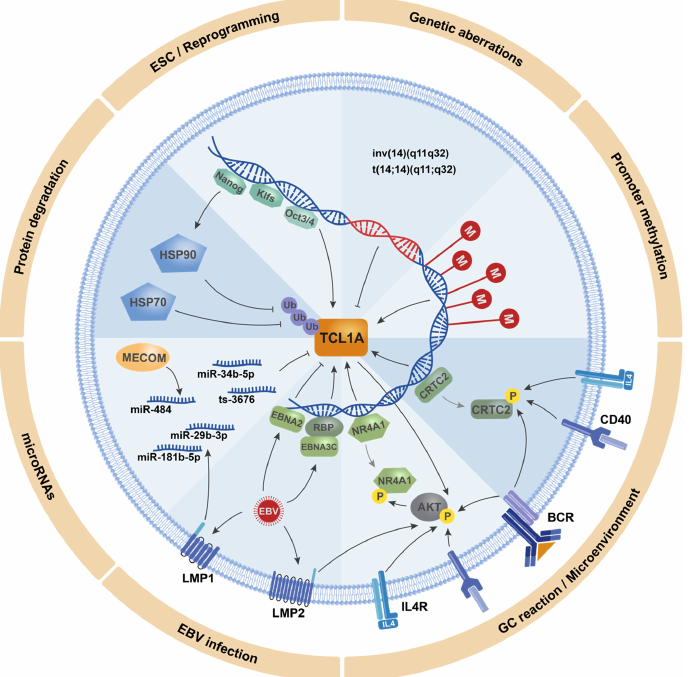
Figure 2. Schematic overview of the different modes of TCL1A regulation (clockwise categories). ESC/Reprogramming: In murine embryonic stem cells (ESCs) and induced pluripotent stem cells (iPSCs), Tcl1a expression is mediated by the transcription factors Nanog [75,76,81], Klf2/4/5 [60,82], and Oct3/4 [70]. Genetic aberrations: In T-cell prolymphocytic leukemia (T-PLL), an inversion or translocation of the TCL1A gene on chromosome 14 positions its locus under control by highly active regulatory regions of T-cell receptor genes. This prevents TCL1A’s post-thymic silencing and causes its constitutive expression [1]. Promoter methylation: During T-cell and B-cell development and maturation, a protracted epigenetic silencing of TCL1A expression is likely. B-cell lines have shown three different patterns of promoter methylation, that might reflect a successive increase in methylation along B-cell differentiation [83]. GC reaction/microenvironment: Signals via the BCR and/or via IL4R and CD40 ligation lead to phosphorylation and nuclear exclusion of CRTC2 [84] and NR4A1 [85], thereby repressing transcriptional activation of TCL1A . EBV infections: These signals by the microenvironment can also be mimicked by the Epstein–Barr virus (EBV) proteins LMP1 and LMP2, leading to repression of TCL1A [86,87]. Furthermore, the EBV protein EBNA2 represses [87], whereas EBNA3C increases, TCL1A expression [88]. MiRNAs: At the post-transcriptional level, TCL1A is regulated by several microRNAs (miRs), whose expressions are deregulated via co-deletion at 13q [89] and 17p [90], the EBV protein LMP1 [86], and the protein MECOM [29]. Protein degradation: Integrity of the TCL1A protein is regulated via the chaperones HSP70 [91] and HSP90 [76] that protect TCL1A from ubiquitination and subsequent degradation. Expression of HSP90 is also regulated by the stem cell factor Nanog, which thereby mediates a bimodal regulation of TCL1A at the gene and protein level [76]. Grey arrows: dissociation from the TCL1A promoter.